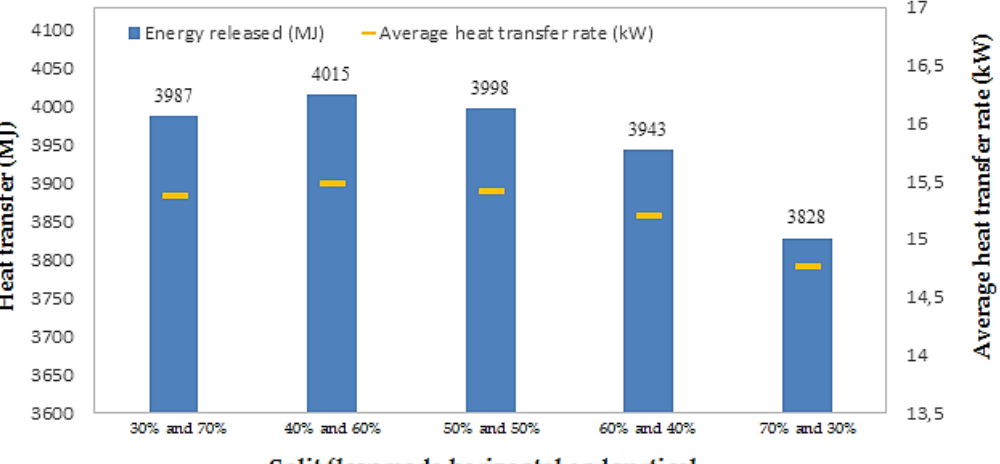
Figure 12. Energy released in 3 days by the GHE with different ratio of mass flow rate in Adelaide (where the inlet fluid temperature = 50 °C, fluid mass flow rate = 0.6 kg/s, length of horizontal GHE = 200 m, and length of vertical GHE = 200 m).